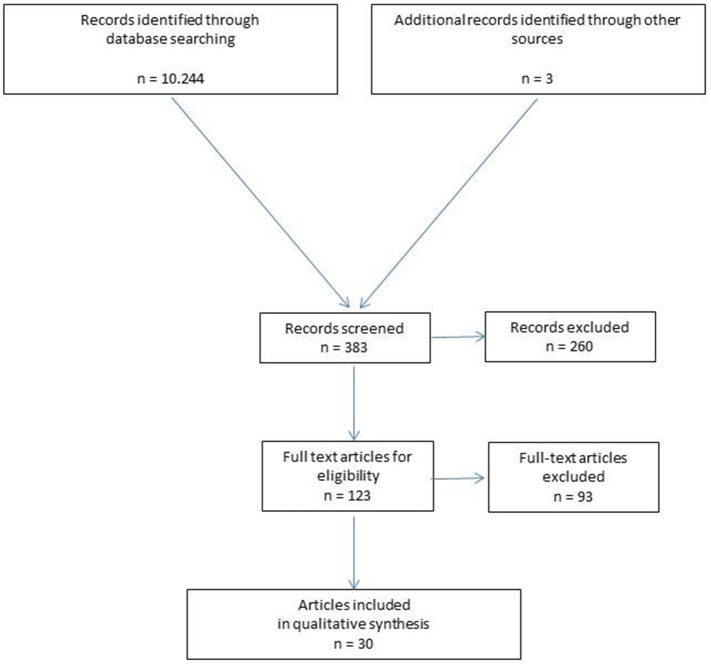
Flowchart of study inclusion.